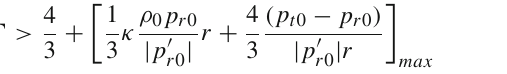
Table 3 The mass and compactness factor for a fixed radius R = 9 . 5 [ km ] and for different values of the parameter